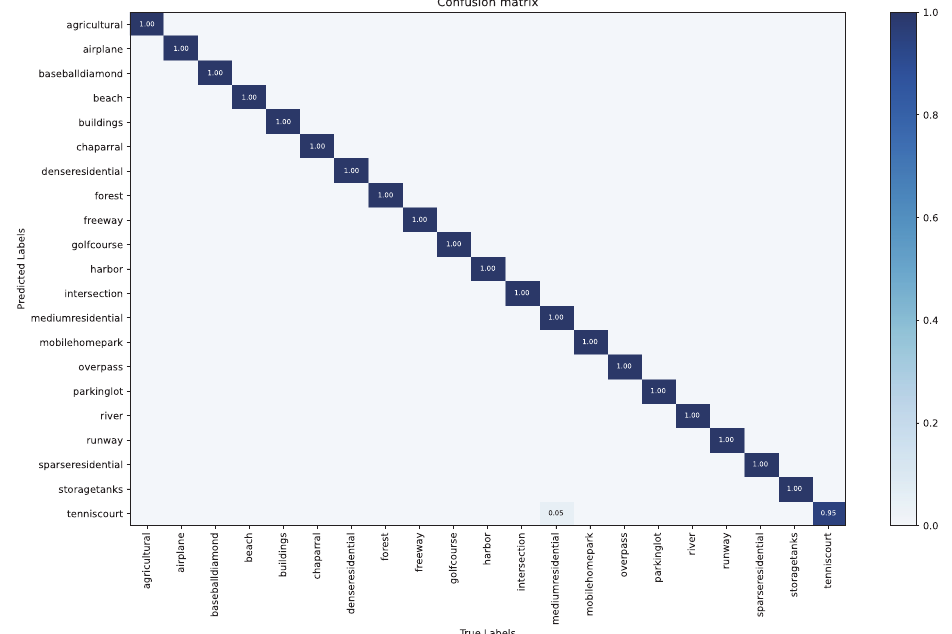
Figure 10. Confusion matrix on the UCM dataset under the training ratio of 80%.